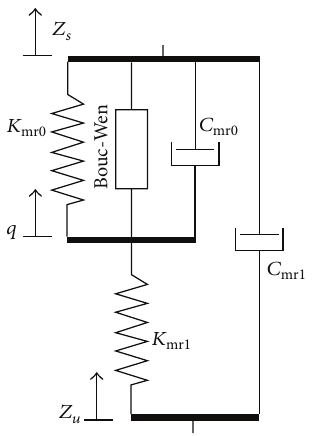
Figure 1: Schematic of Spencer model.